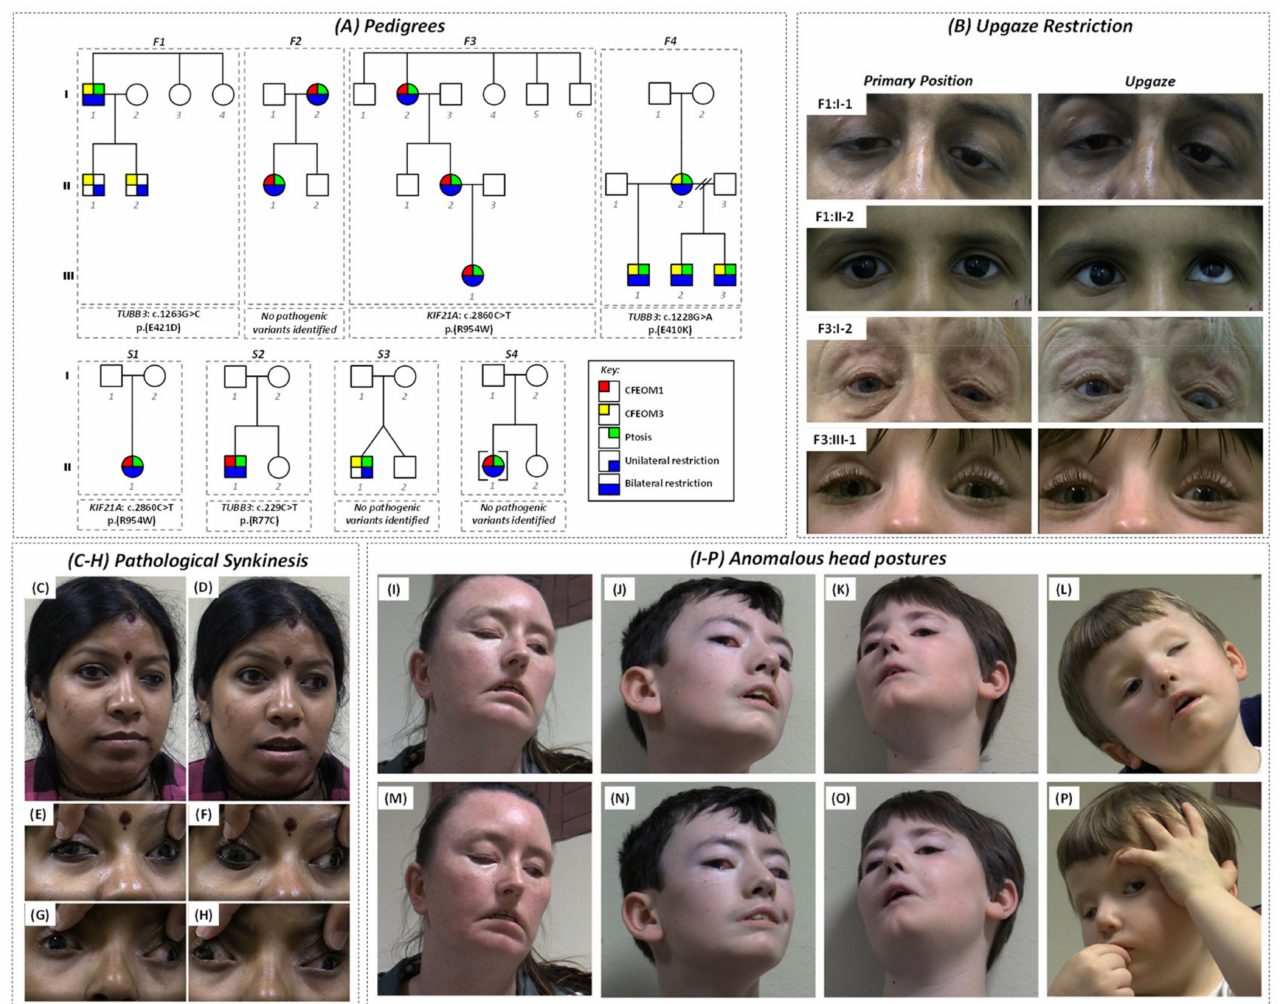
Figure 1. ( A ) Pedigrees of families (F1–F4) and singletons (S1–S4) diagnosed with congenital fibrosis of the extraocular muscles. Genotypes are shown below the pedigrees. ( B ) Eye position in subjects with congenital fibrosis of extraocular muscles when observing a target located centrally (primary position) and superiorly (upgaze). Subject F1:I-1 has bilateral blepharoptosis, left esotropia, and no elevation in both eyes. However, his son (subject F1:II-3) has CFEOM3 phenotype limited to the right eye; he is unable to elevate the eye above the midline. There was no blepharoptosis and ductions were normal for the left eye. Subject F3:I-2 and subject S1:II-1 exhibited a CFEOM1 phenotype with bilateral blepharoptosis and inability to elevate either eye. Subject F3:I-2 also had a left exotropia and hypotropia. ( C – H ) Congenital pathologic synkinesis showing Marcus Gunn jaw winking phenomenon and synergistic divergence. Subject F2:I-2 had bilateral blepharoptosis, face turn to the left, and left exotropia with hypotropia ( C ). Retraction of the left upper eyelid is observed with mouth opening ( D ). Eye positions on central fixation ( E ) and downgaze ( F ) are shown. Synkinetic abduction of the left eye is observed on infraversion. Similar to F2:II-1, there is synkinetic abduction from central fixation ( G ) to downgaze ( H ). ( I – P ) Abnormal head postures observed when fixing at a target centrally in family F4 ( I – L ). Subjects F4:I-2 ( I ) and F4:II-1 ( J ) exhibit chin up and face turn to the left. Subject F4:II-2 has a head turn to the right with chin up position ( K ). Subject F4:II-3 has head tilt to the right with chin up position ( L ). All subjects had large angle exotropia. Facial weakness is demonstrated in all subjects when asked to smile ( M – O ). Drooping of the corner of the mouth and flattening of forehead and nasolabial folds are seen. Subject F4:II-3 had severe blepharoptosis of the left eye and frequently raised his upper left eyelid and brow using his finger in order to fixate with the left eye ( P